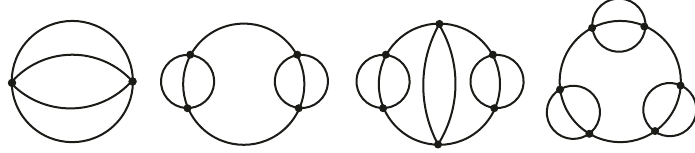
Figure 1 . All the melonic vacuum diagrams up to order g 6